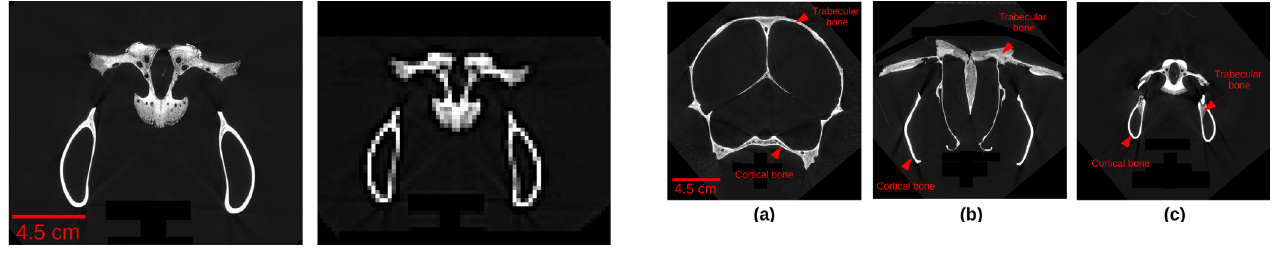
Figure 1. A slice of the CT scan images illustrating the mandible and teeth at the original voxel size (left) and the dowsampled processed image (right).